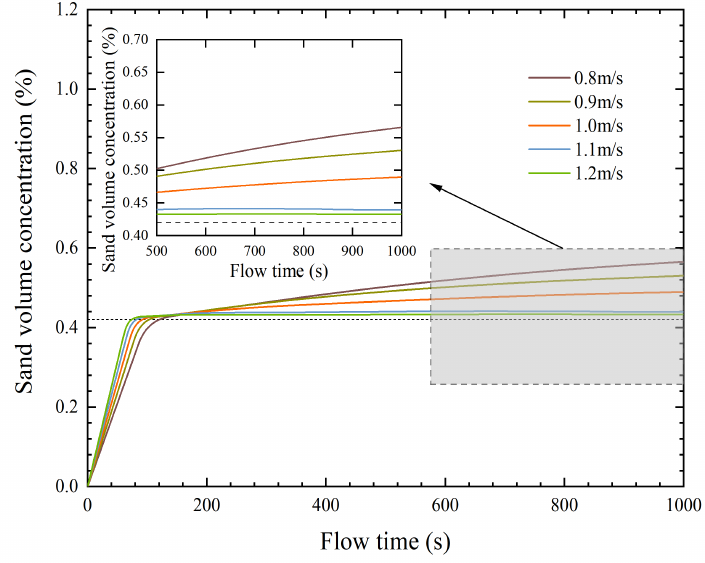
Figure 16. Sand volume concentration changes with flow time (V-inclined pipe L = 80 m d = 0.05 mm).